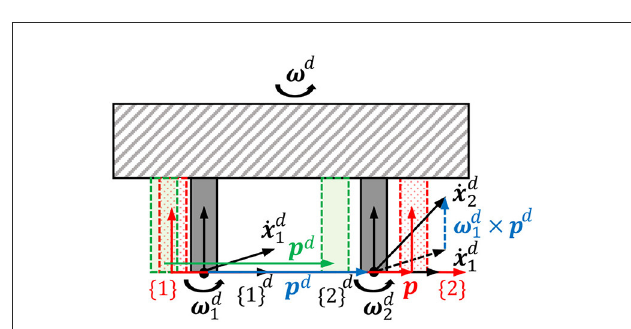
FIGURE4 Rigid body constraint between the two real handles imposed by their virtual counterparts, which are attached to the same rigid body in the